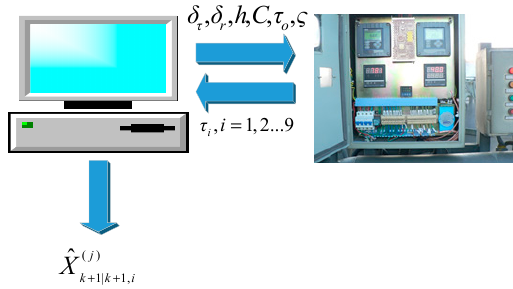
Figure 17. Processing flow of the experimental data.